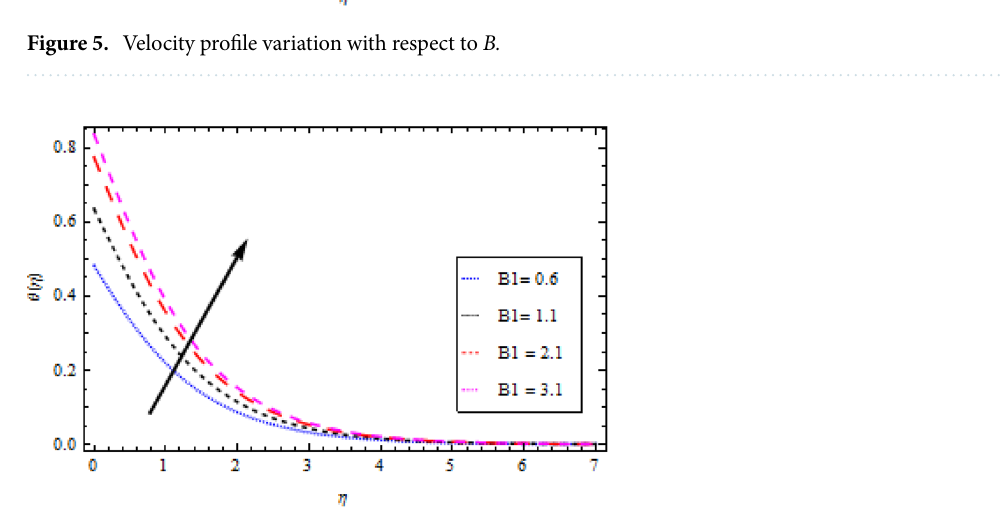
Figure 6. Temperature profile variation with respect to B 1